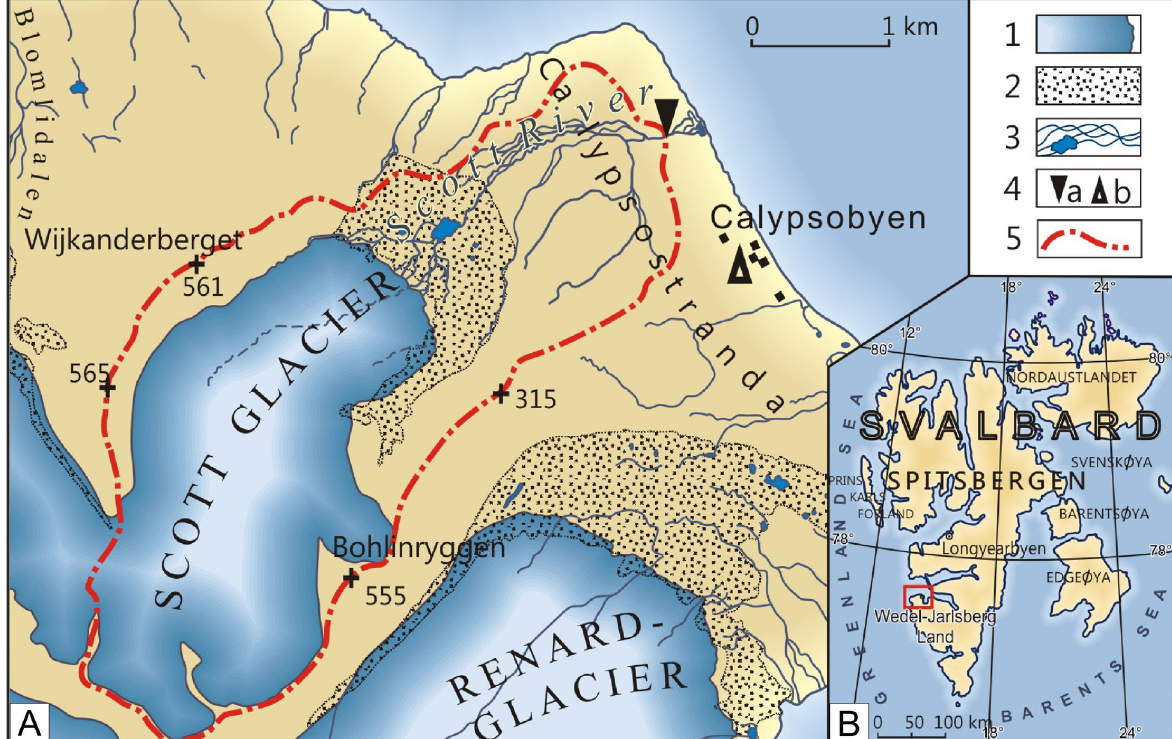
Fig. 1. A – Location of the study area: 1 – valley glaciers, 2 – glacial accumulation zones, 3 – rivers and water bodies, 4a – water gauge station; 4b – meteorological station, 5 – border of the Scott River catchment. B – Location of the study area on Svalbard